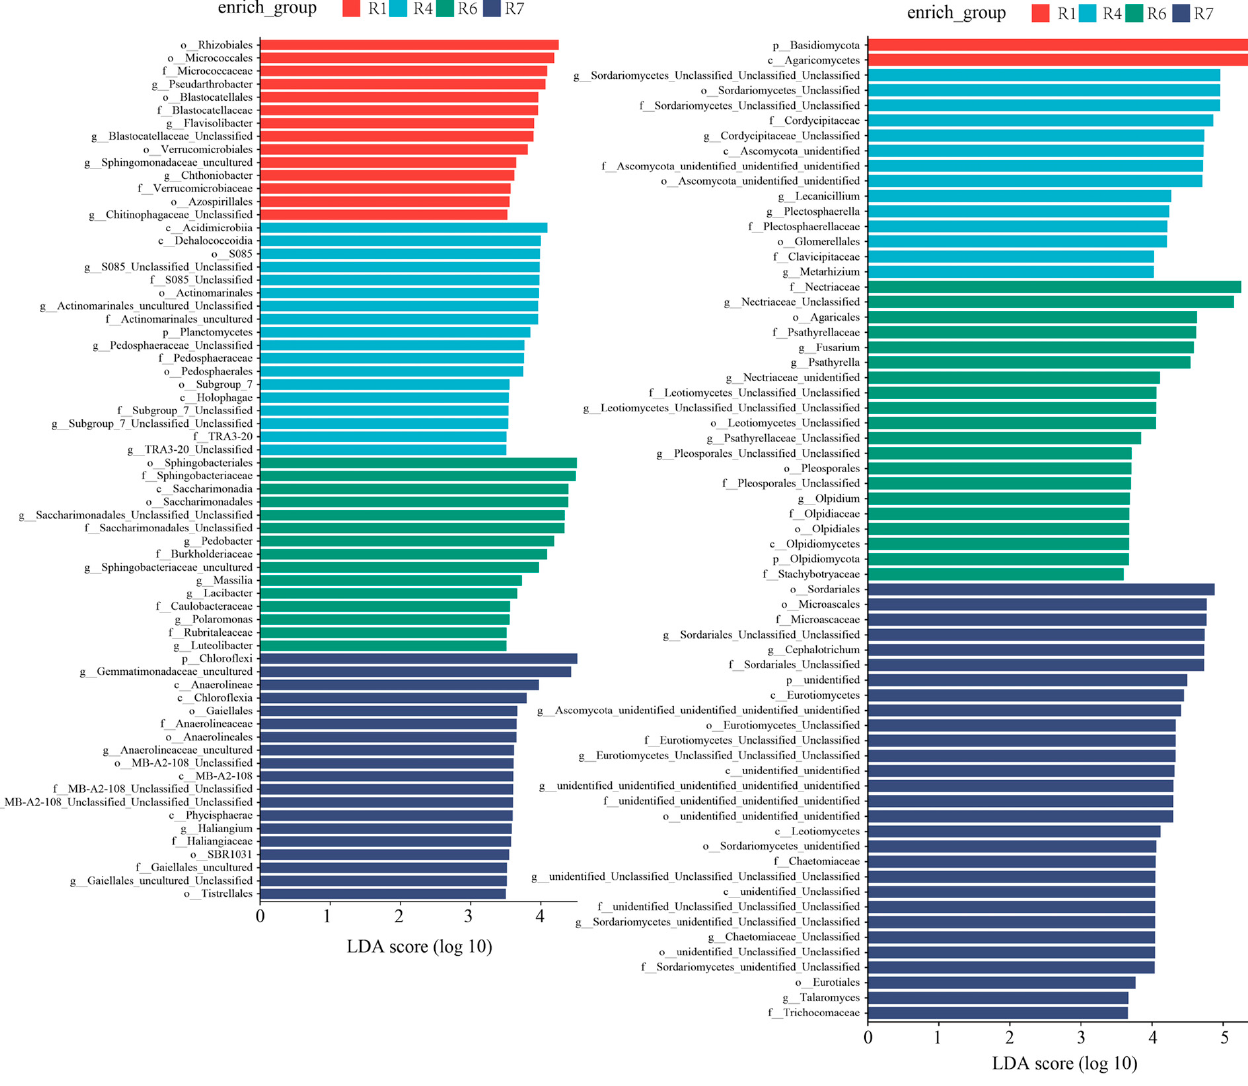
Figure 4. LEfSe analysis of the rhizosphere bacterial and fungi community from the phylum to species rank across the different varieties (1,6 indicate the rot-conducive variety; 4,7 indicate the rot-suppressive variety) and farming modes (1,4 belong to monoculture mode; 6,7 belong to rotation mode).